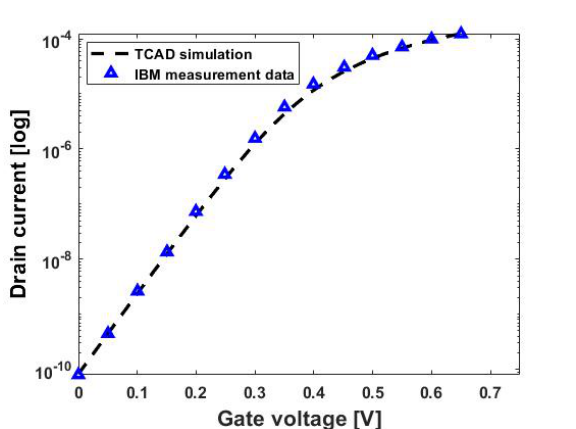
Figure 2. Calibrated I-V curve with the IBM measurement data.